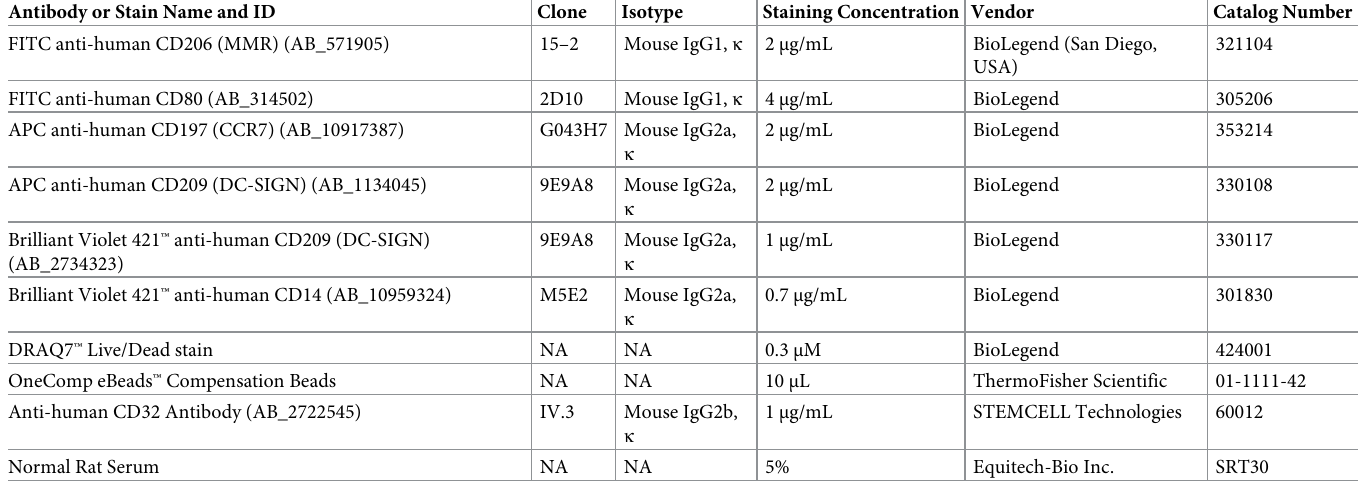
Table 2. Materials used for flow cytometry of macrophages. Antibody or Stain Name and